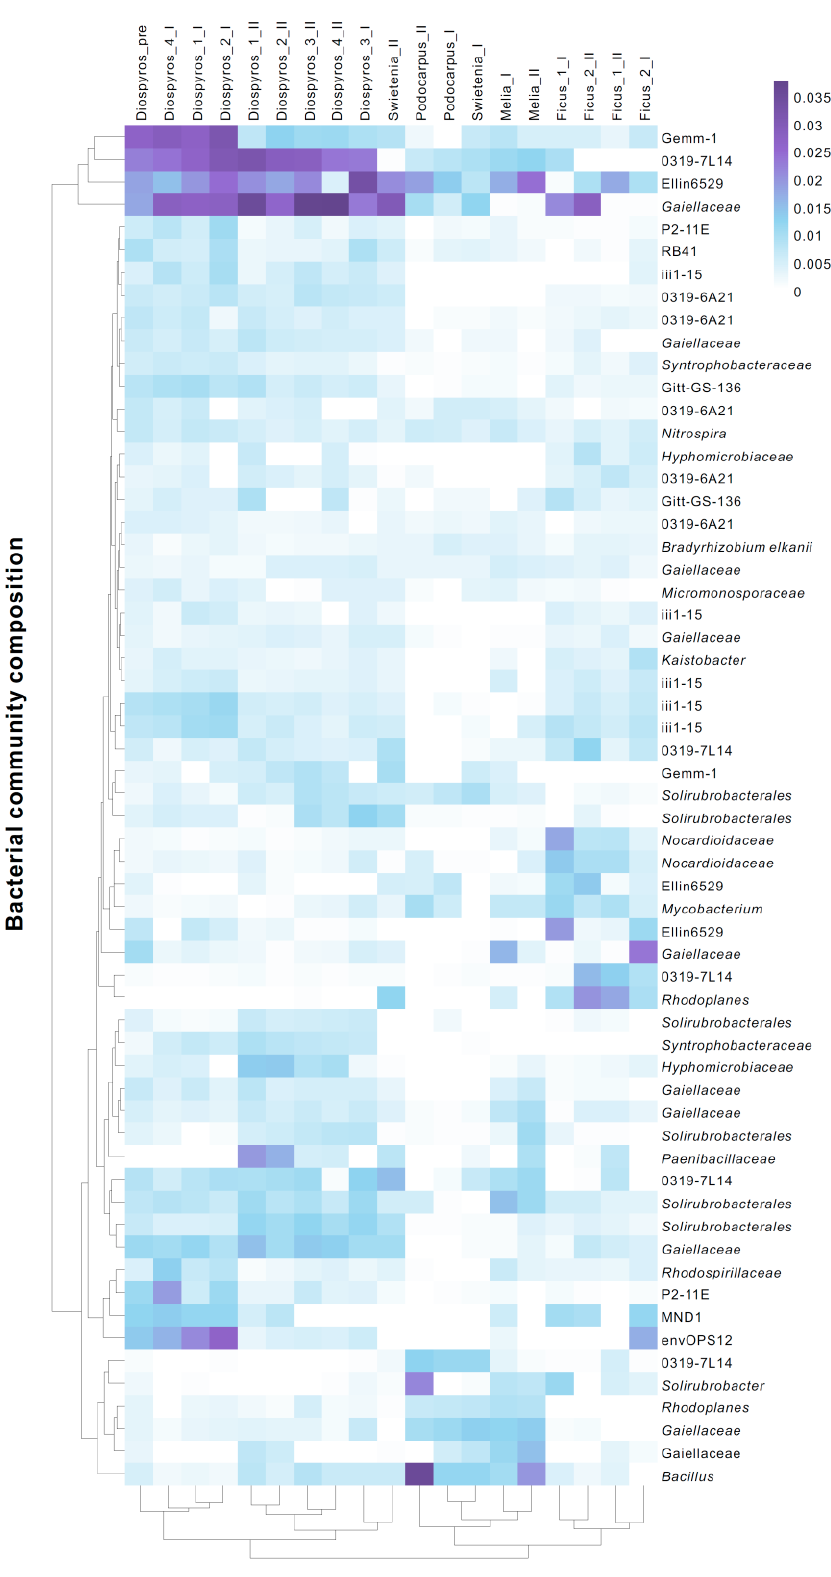
Figure 3. The heat map of the 60 dominant bacteria species associated with individual urban trees across treatments. Diospyros = D. blancoi , Swietenia = S. macrophylla , Melia = M. azedarach , Podocarpus = P. nakaii , and Ficus = F. microcarpa . Pre denotes the original soil; I and II denote soil after the addition of biochar and of biochar/compost in combination, respectively.